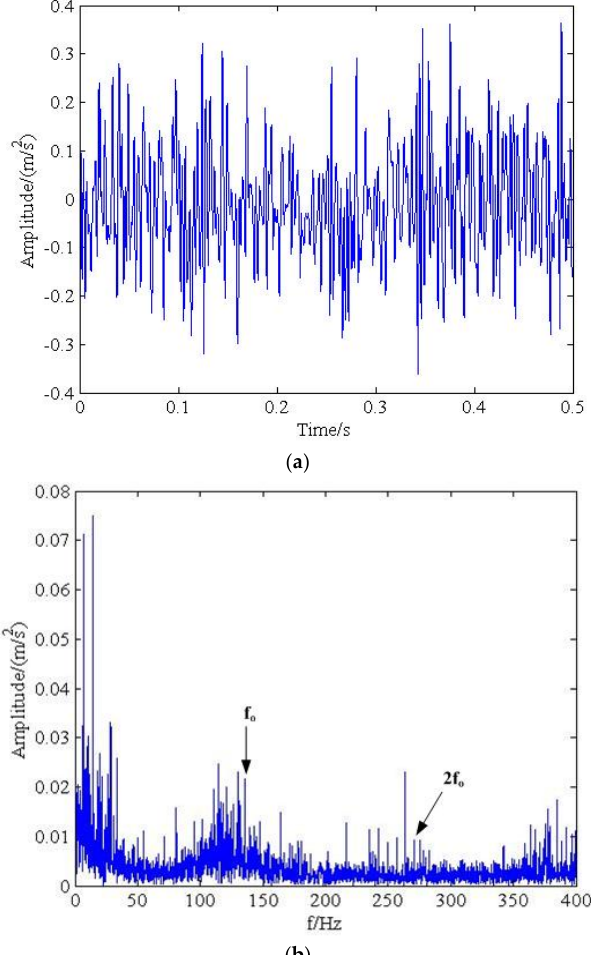
Figure 9. Result provided by wavelet denoising. ( a ) Result of wavelet denoising in time ‐ domain; ( b ) Result of wavelet denoising in frequency ‐ domain.